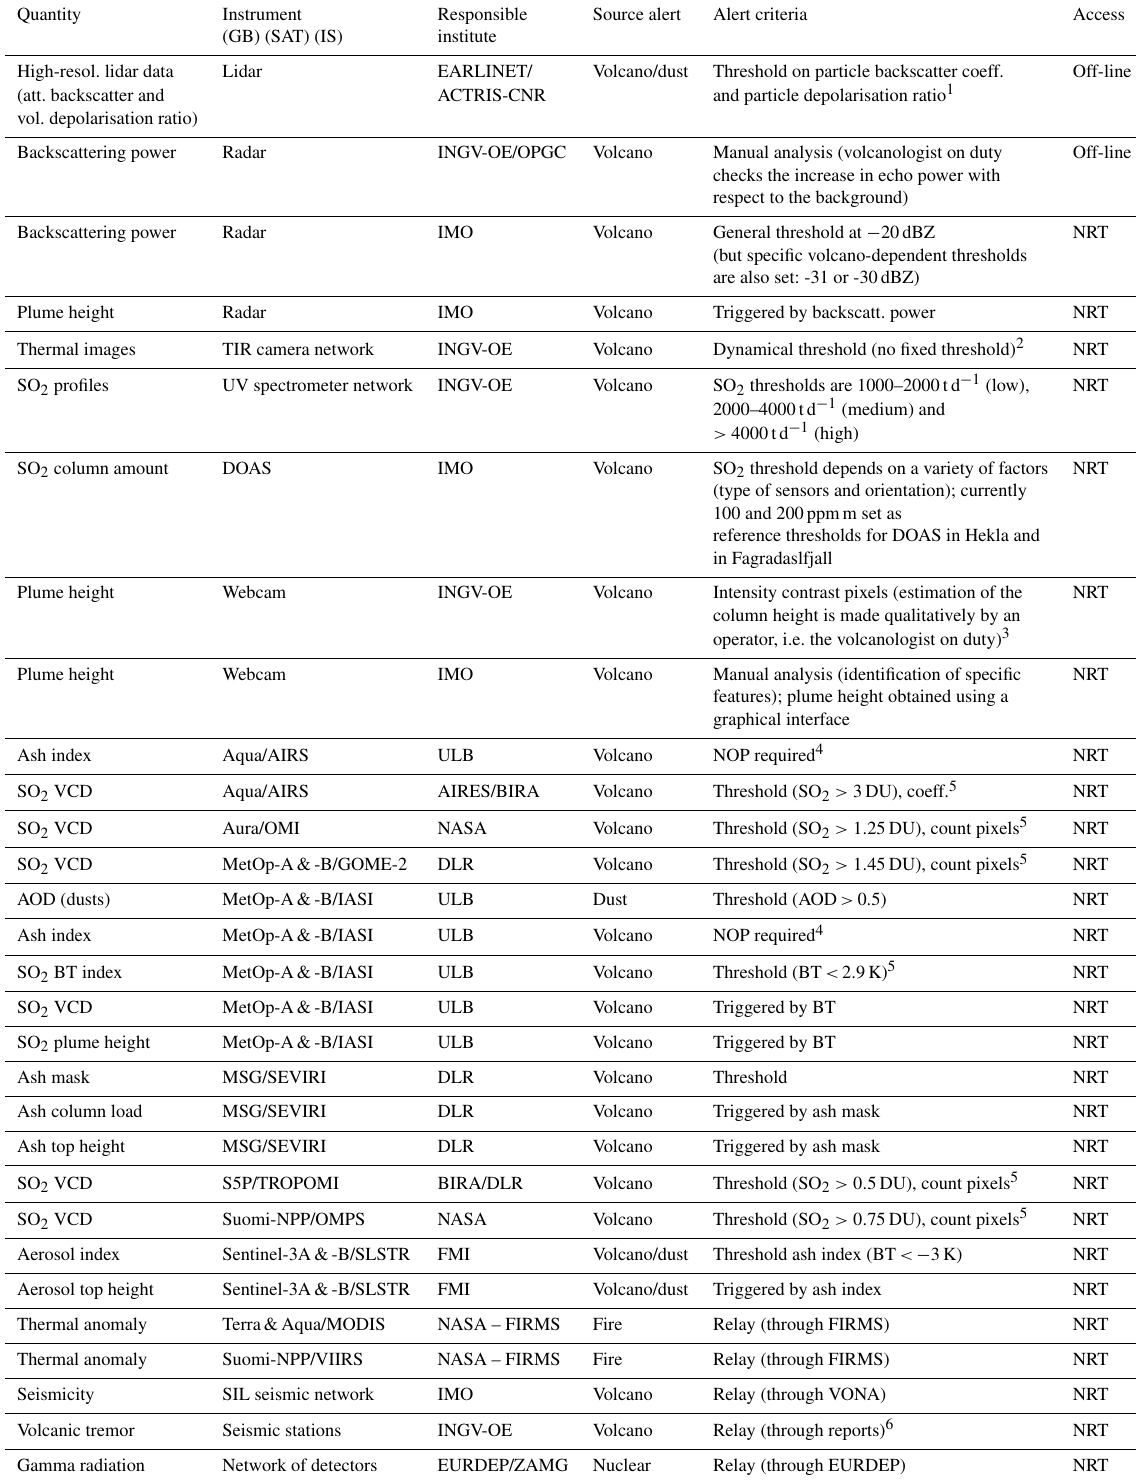
Table 5. Overview of EUNADICS-AV alert products from ground-based (GB), satellite (SAT) and in situ (IS) instruments. DOAS: differential optical absorption spectroscopy. OPGC: Observatoire de Physique du Globe de Clermont-Ferrand. S5P: Sentinel-5 Precursor. TIR: thermal